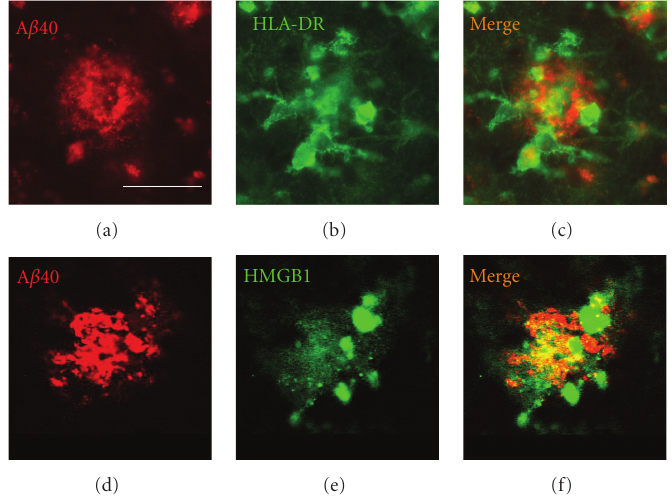
Figure 6: Laser confocal microscopic study on the accumulation of HMGB1 and microglia on A β 40 plaques in human AD brains. (a–c) Free-floating human AD brain sections were incubated with the anti-A β 40 specific antibody ((a) red) and anti-HLA-DR antibody ((b) for microglial staining, green). The merged image is indicated in (c). (d–f) Free-floating human AD brain sections were incubated with the anti-A β 40 specific antibody ((a); red) and anti-HMGB1 antibody ((b); green). The merged image is indicated in (f). Scale bar in (a) equals 50 μ m for all